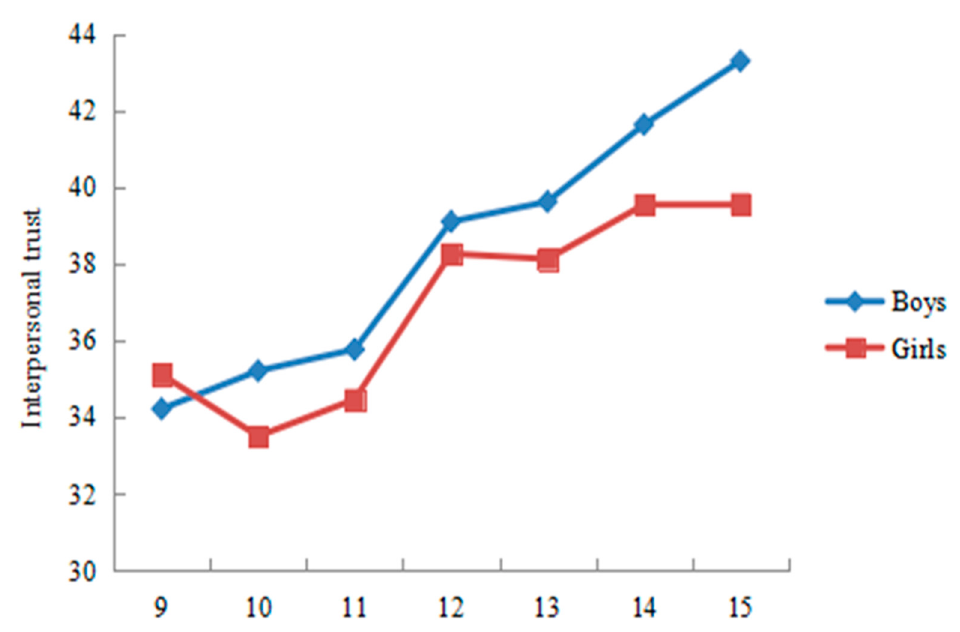
Figure 3. The total score of health-related quality of life by age and gender. Note: Higher score of interpersonal trust represents interpersonal mistrust.